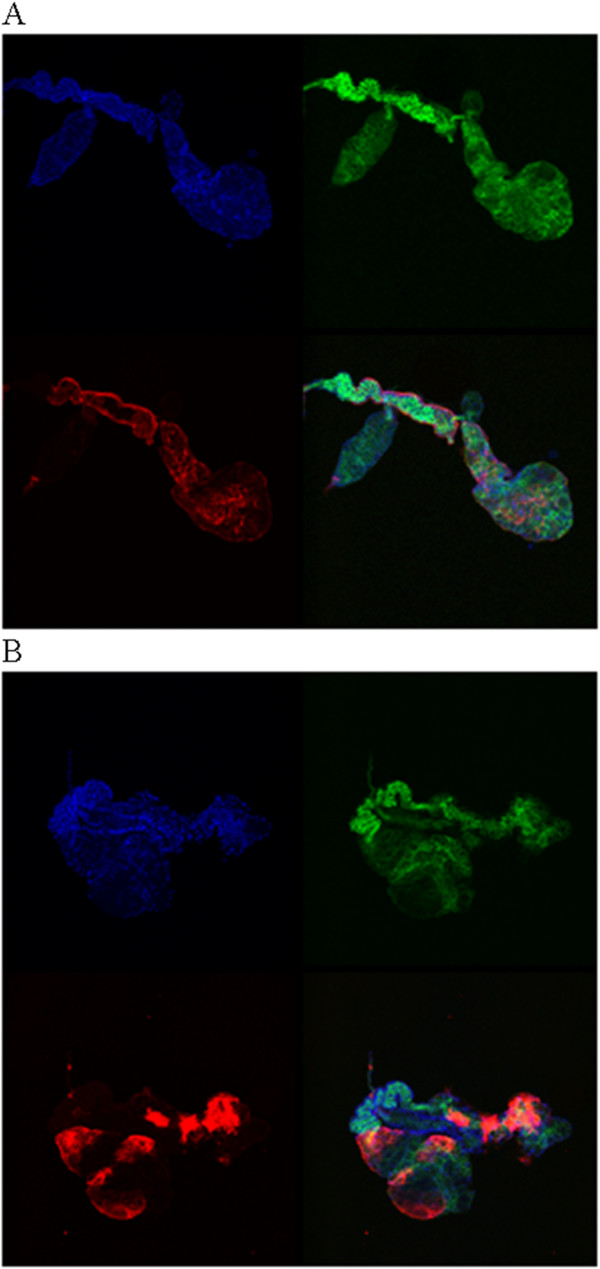
Distribution of CHIKV in 3DPI and 5DPI Ae. aegypti salivary glands. Salivary glands were dissected at 3 DPI (A) and 5 DPI (B). CHIKV labelled in red was identified using 3E4 anti-CHIKV according to the protocol described in the Methods section. Nuclei were labelled in blue using DAPI. Alexafluor 488-labelled phalloidin was used to label the actin network in green. A superimposition of all labelling is also shown.